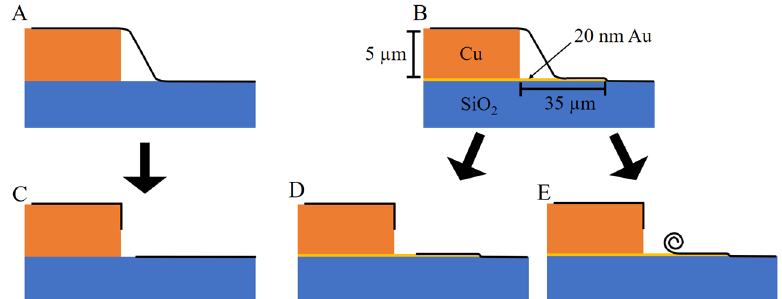
Figure 4. Metallic contact between copper and the 2D material: ( A ) the case where the material is contacted directly to copper; ( B ) the case where the material is contacted with a 20 nm thick gold contact; ( C ) the consequence of undertaking scenario A and demonstrating the 2D material breaking and not making contact with copper; in ( D ) the consequence of scenario B, where the contact between the copper and 2D material is mediated through a 20 nm thick gold contact and the 2D material lays flat; ( E ) the consequence of scenario B, where the contact between the copper and 2D material is mediated through a 20 nm thick gold contact, and the material breaks and rolls back.